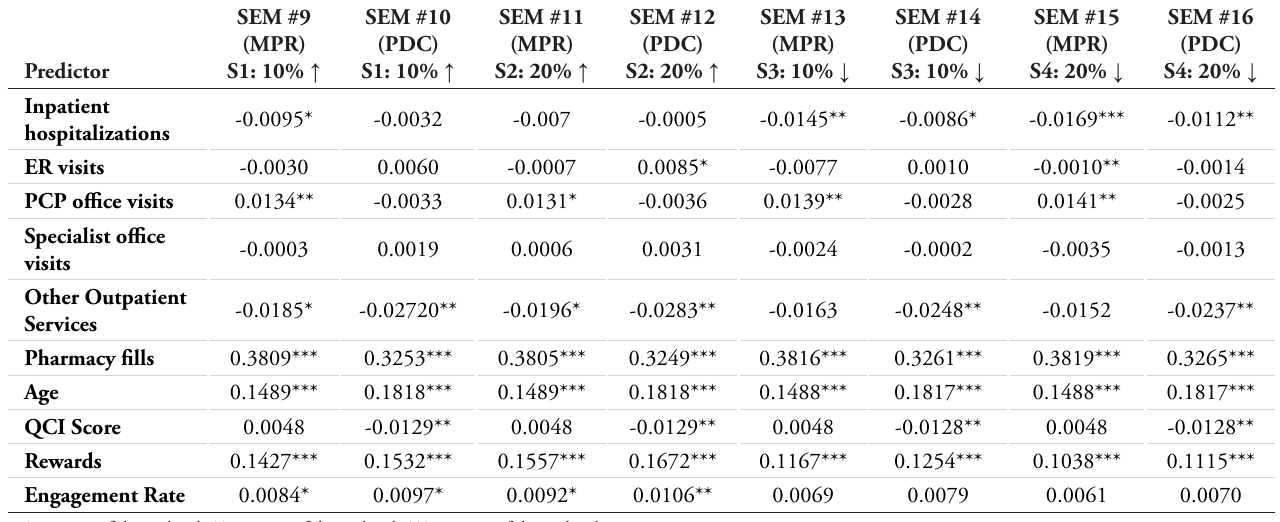
Table 6. Sensitivity Analysis: Total Effects on Adherence Rate for Four Scenarios